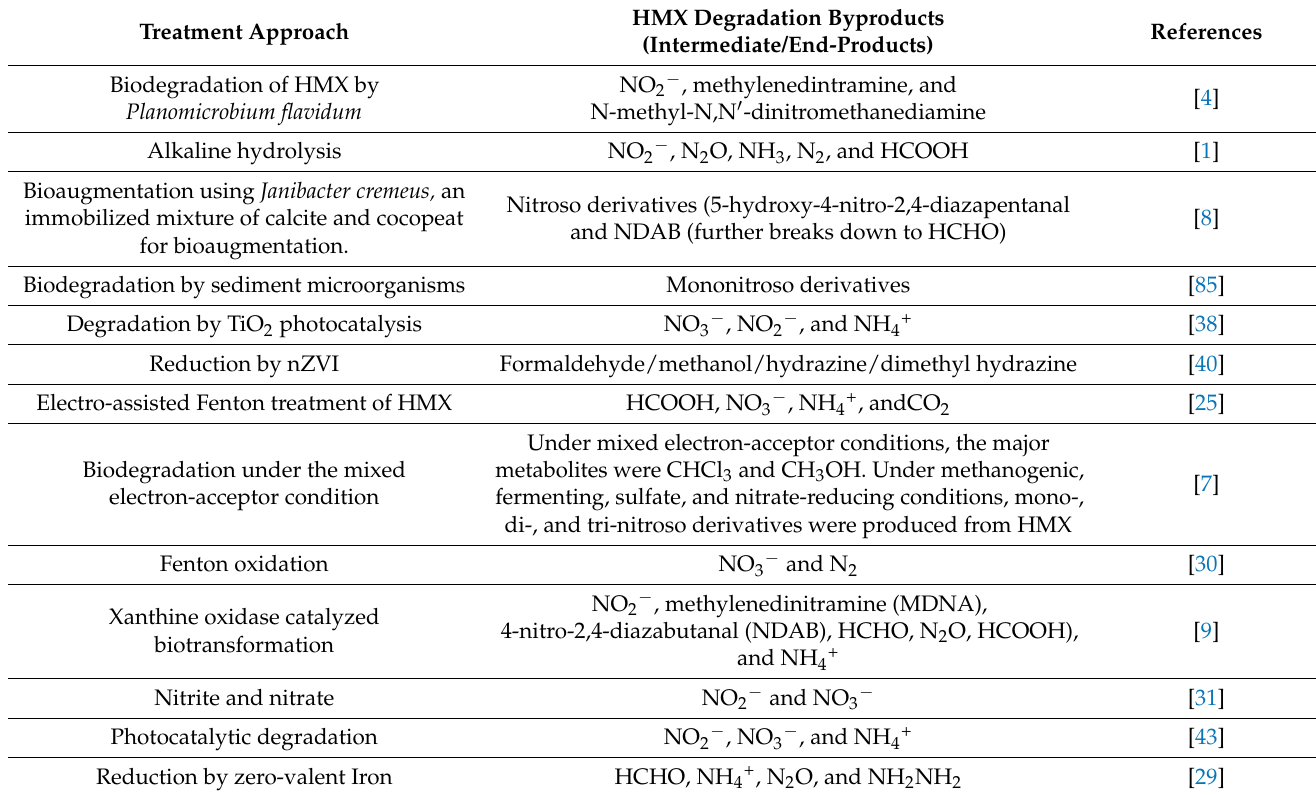
Table 4. Byproducts/end-products of HMX degradation via different treatment approaches.